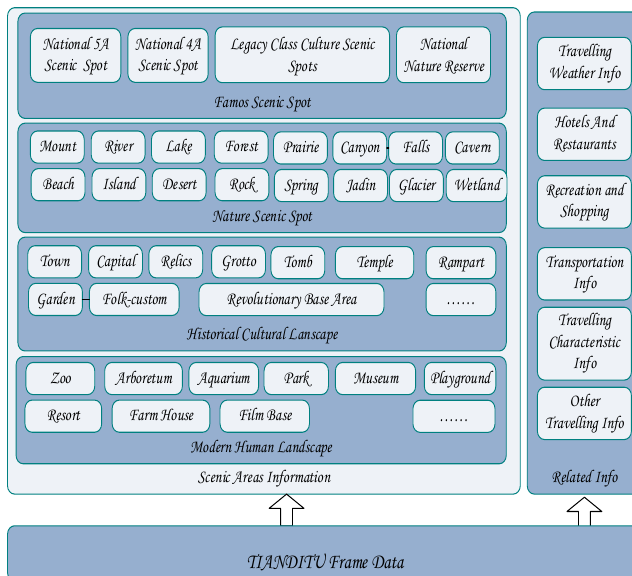
Figure 2: Geographic Information for